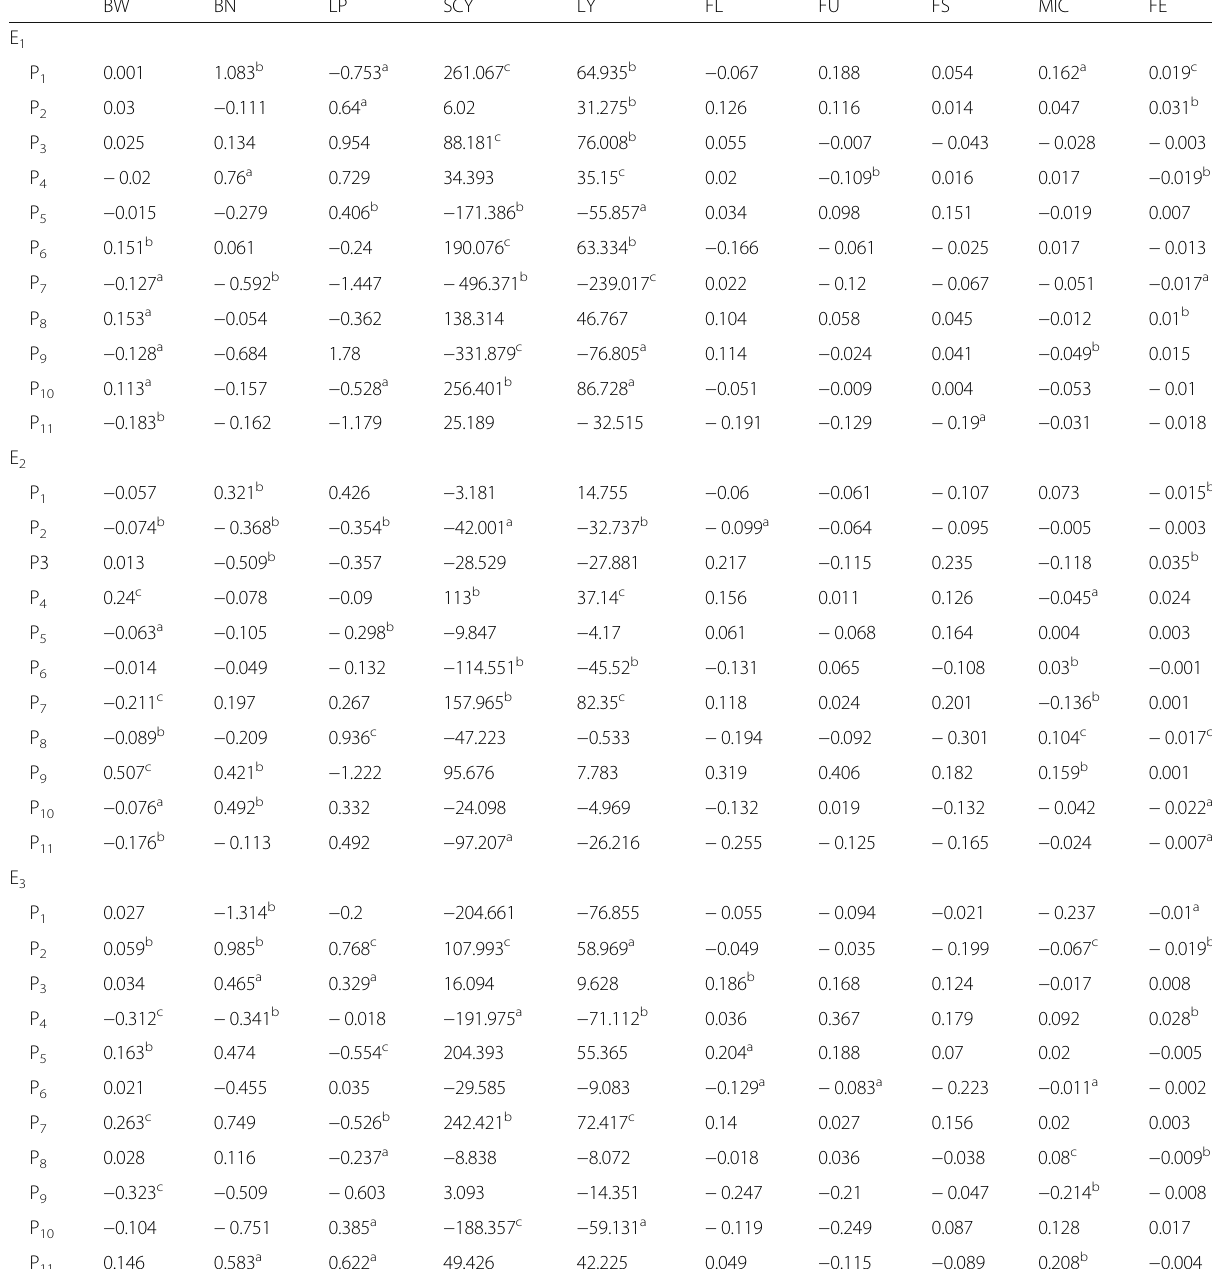
Table 4 Predicted additive-environment interaction effects for yield, yield components, and fiber quality traits in three locations based on 2 years field